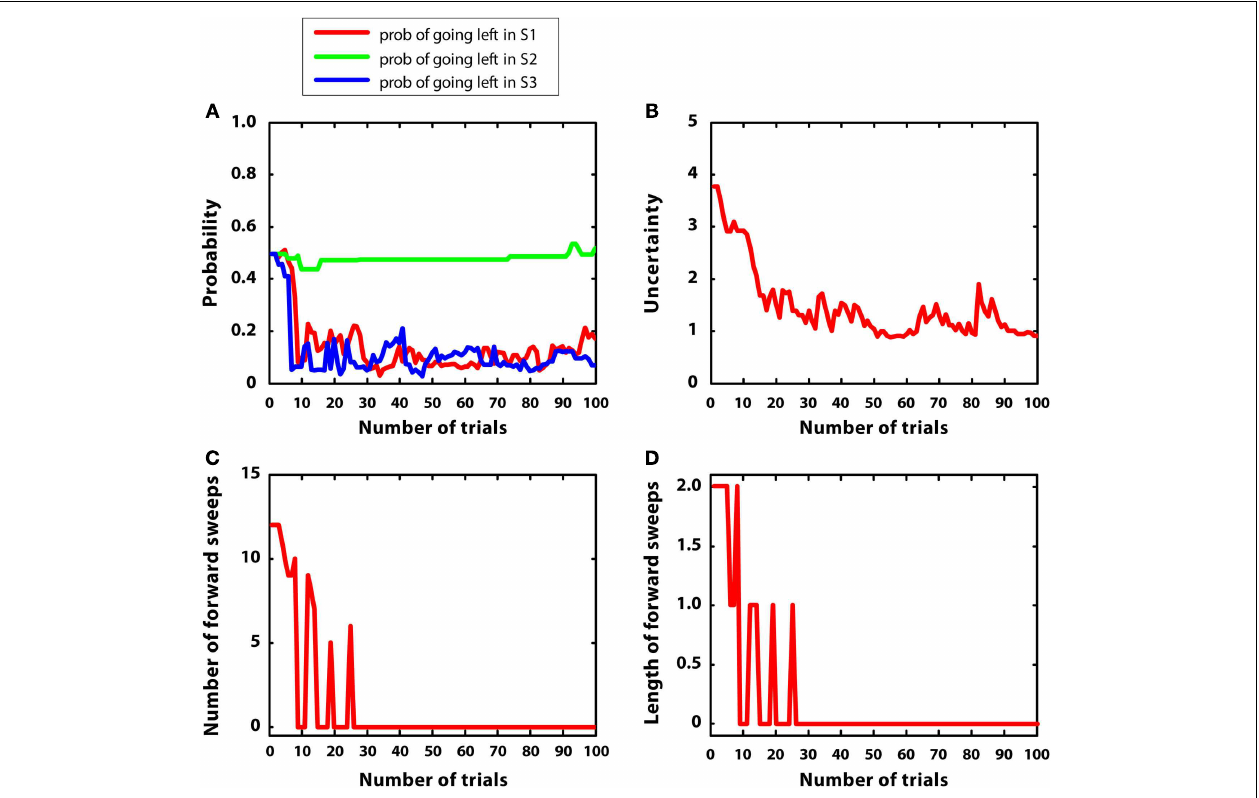
FIGURE 8 | Results of simulation 4, simple environment with high variance. (A–D) : see Figure 5